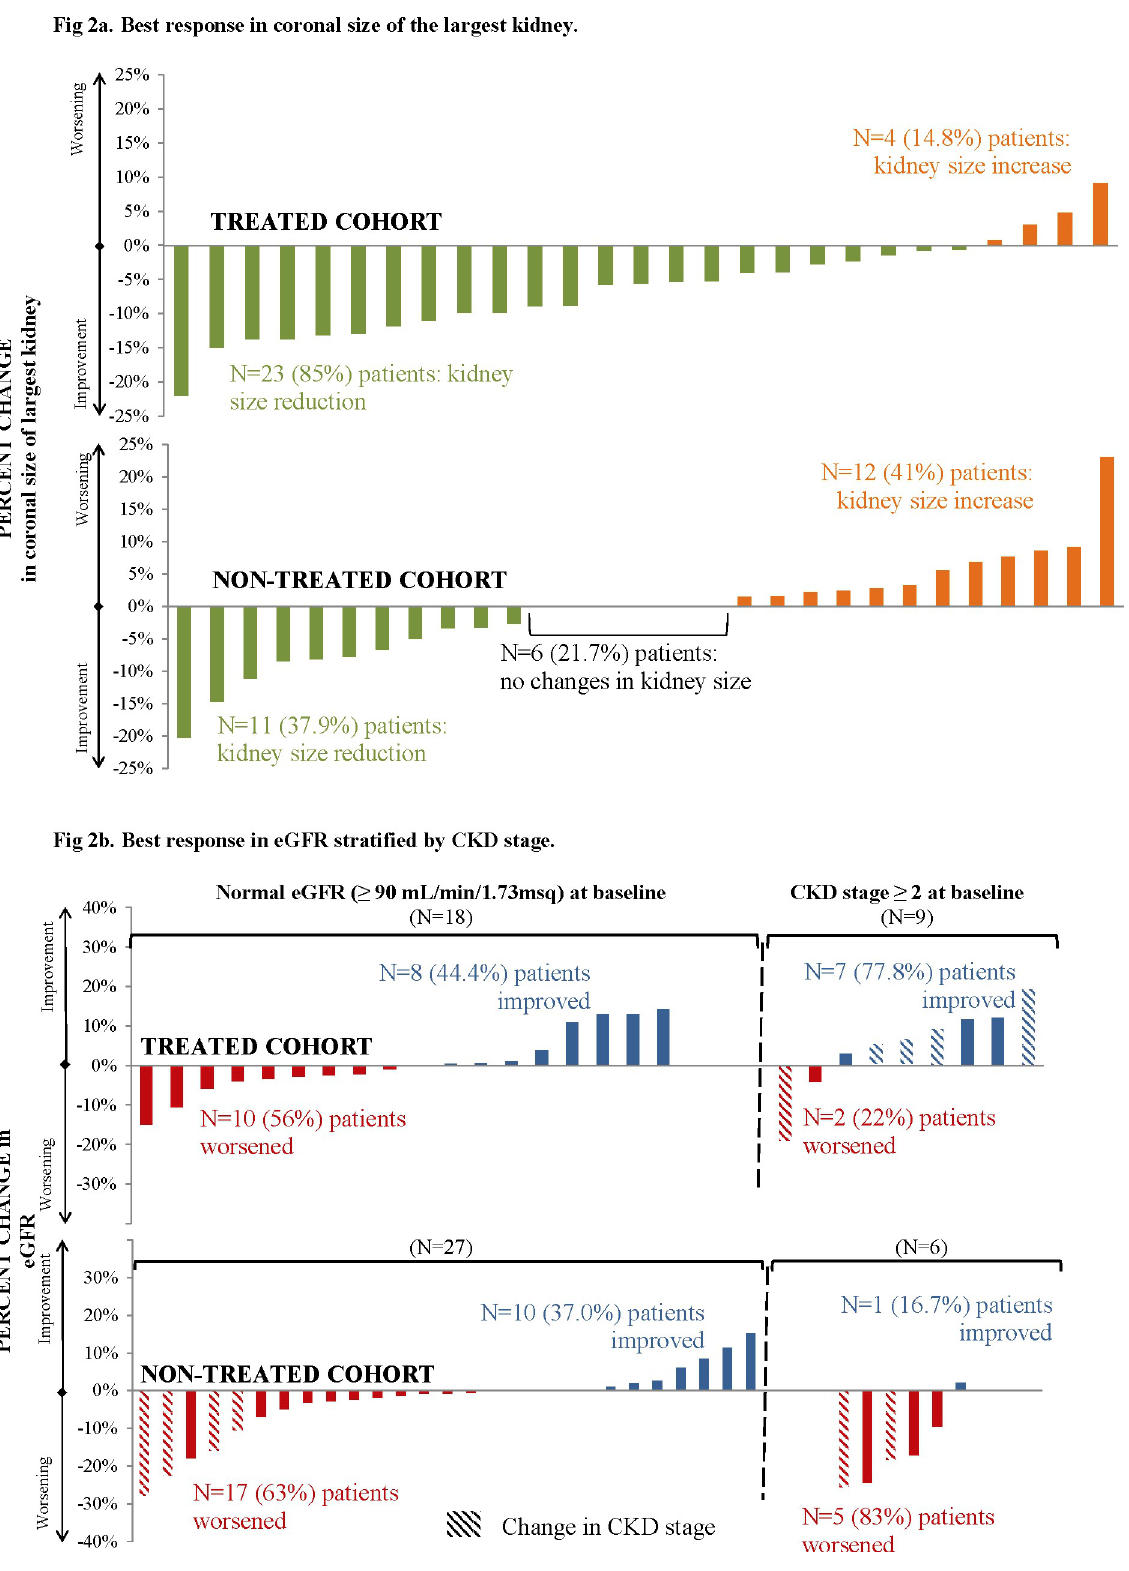
Fig 2. Best response in outcomes in treated versus non treated patients. a. Best response in coronal size of the largest kidney. b. Best response in eGFR stratified by CKD stage. eGFR: estimated glomerular filtration rate; CKD: chronic kidney disease.